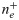
AUPR score as a function of percentile-based similarity θ, for n−/n+ = 10, a number of extra-task positive pairs ne+ = 10 and a ratio of ne-/ne+ = 1 for extra-task pairs.Numerical values can be found in Supporting Information S13 Table.